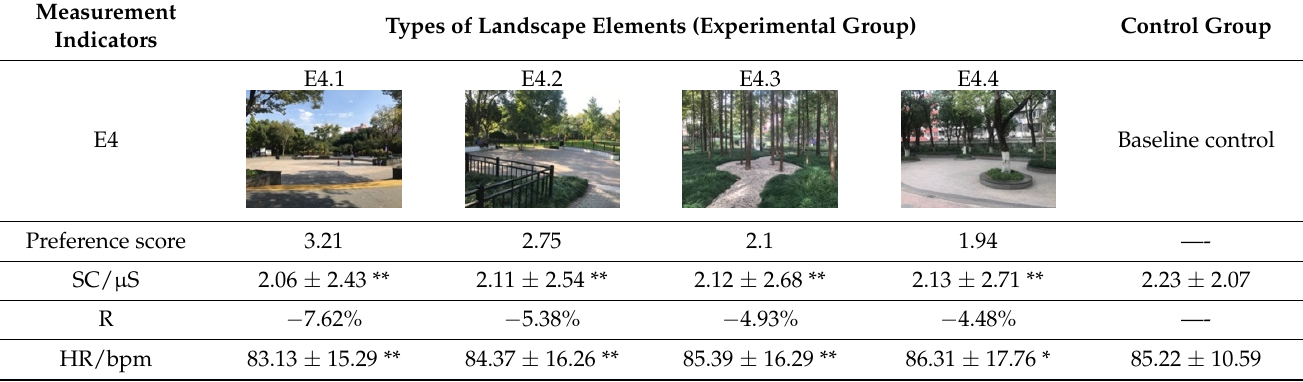
The experiment uses different scene photographs of the activity space to study the influ- ence of activity spaces with different areas and site characteristics on the emotions of the ence of activity spaces with different areas and site characteristics on the emotions of the participants. The specific scenarios are shown in Table 13. participants. The specific scenarios are shown in Table 13. Table 13. Physiological indicators of participants before and after the measurement in response to different activity spaces. Table 13. Physiological indicators of participants before and after the measurement in response to different activity spaces. Table 13. Physiological indicators of participants before and after the measurement in response to different activity spaces. Table 13. Physiological indicators of participants before and after the measurement in response to different activity spaces. Table 13. Physiological indicators of participants before and after the measurement in response to different activity spaces. Table 13. Physiological indicators of participants before and after the measurement in response to different activity spaces. Table 13. Physiological indicators of participants before and after the measurement in response to different activity spaces. Table 13. Physiological indicators of participants before and after the measurement in response to different activity spaces. Table 13. Physiological indicators of participants before and after the measurement in response to different activity spaces. Table 13. Physiological indicators of participants before and after the measurement in response to different activity spaces. Measurement Indi- Measurement Indi- Measurement Indi- Measurement Indi- Measurement Indi- Measurement Indicators